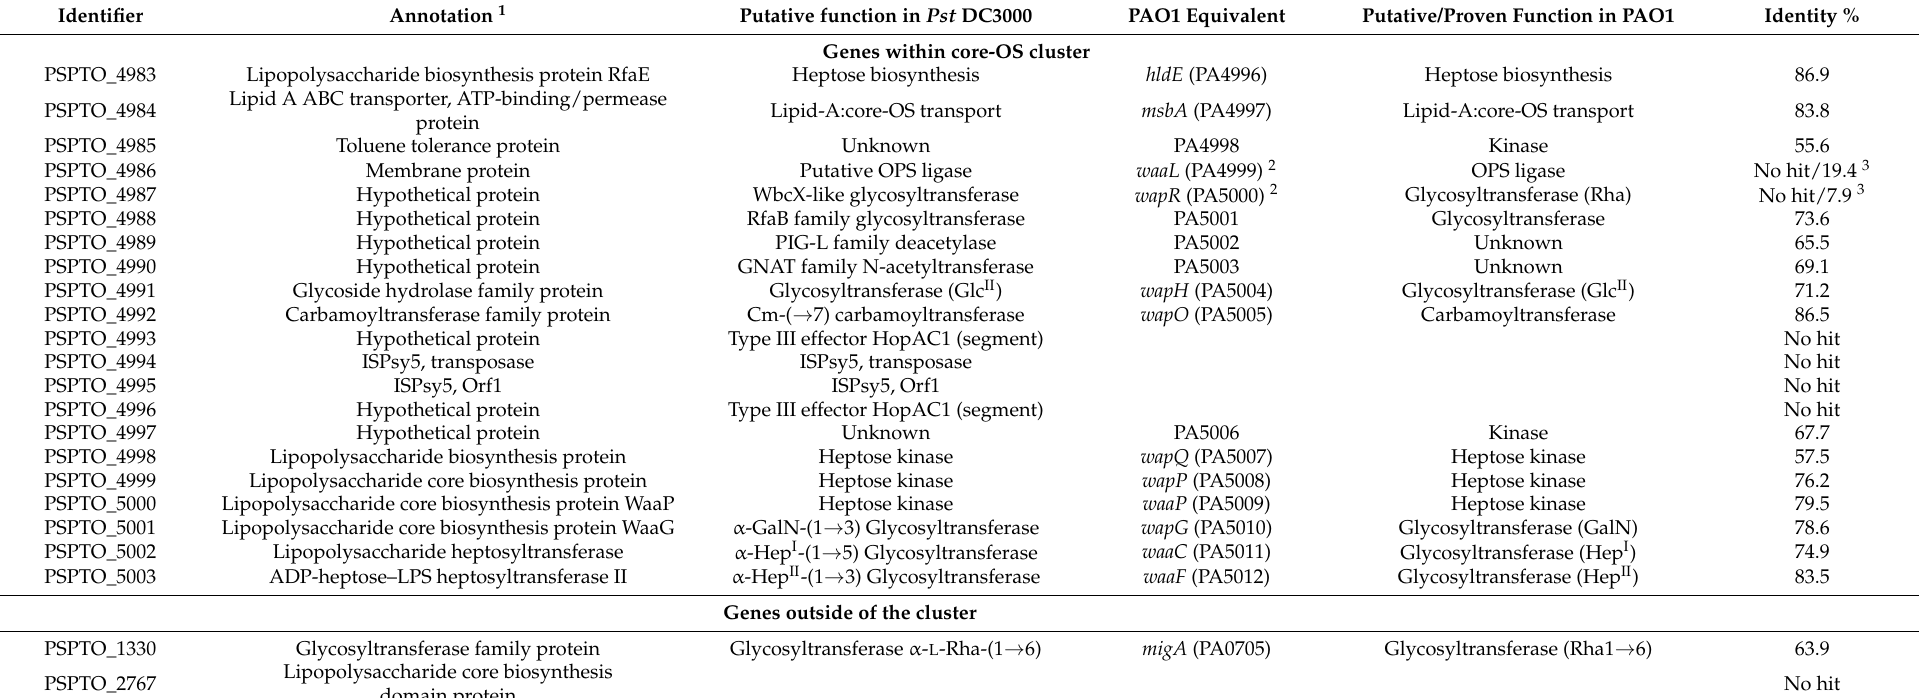
Table 1. Genes of the core oligosaccharide (core-OS) cluster and putative function of the encoded enzymes in Pseudomonas syringae pv. tomato DC3000 in comparison to P. aeruginosa PAO1 based on publicly available